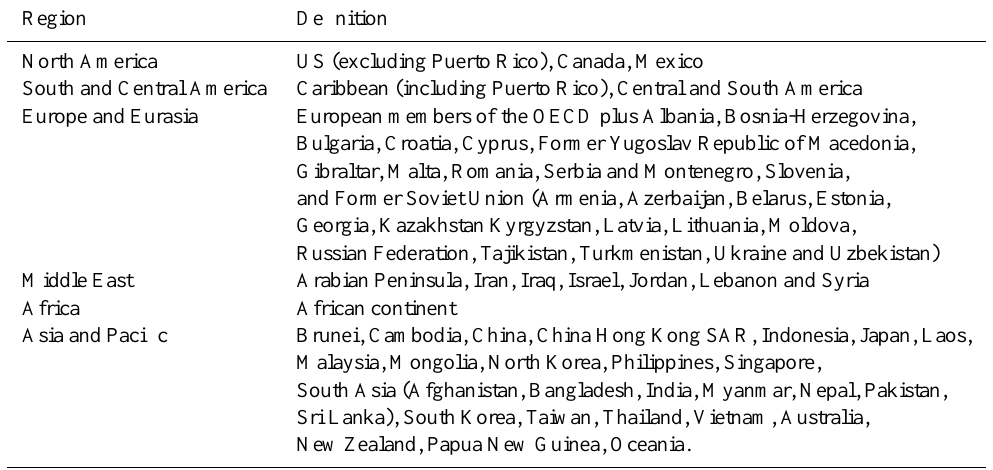
Table 2. Definition of geographic regions in this study. This definition was adopted from BP